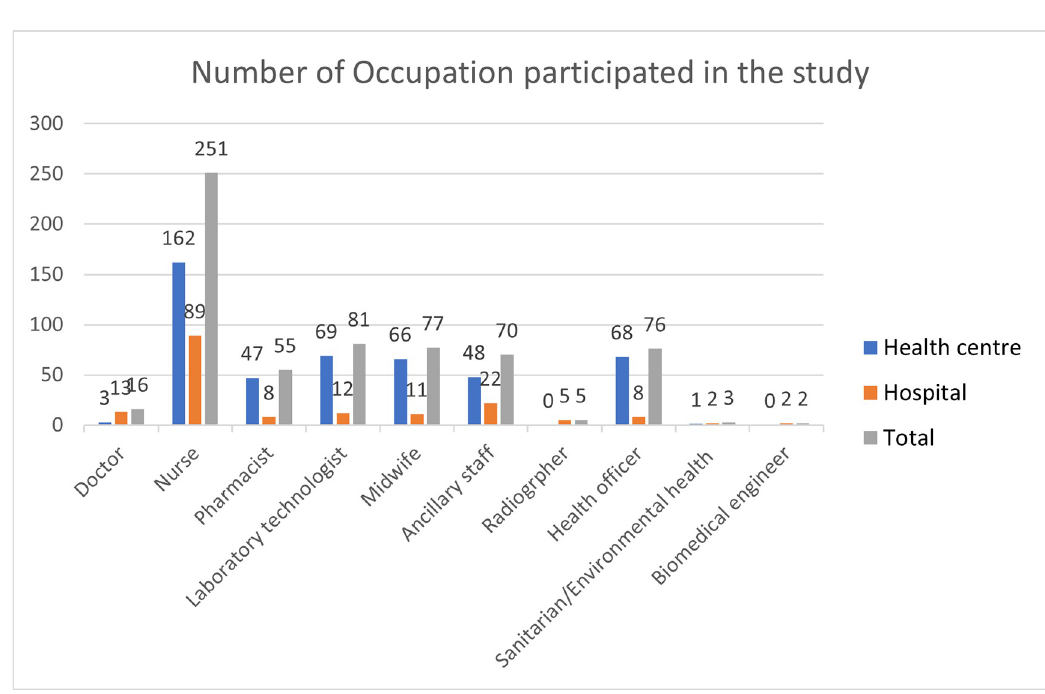
Fig 3. Number of respondents by occupation, Addis Ababa City Administration, February 2018.